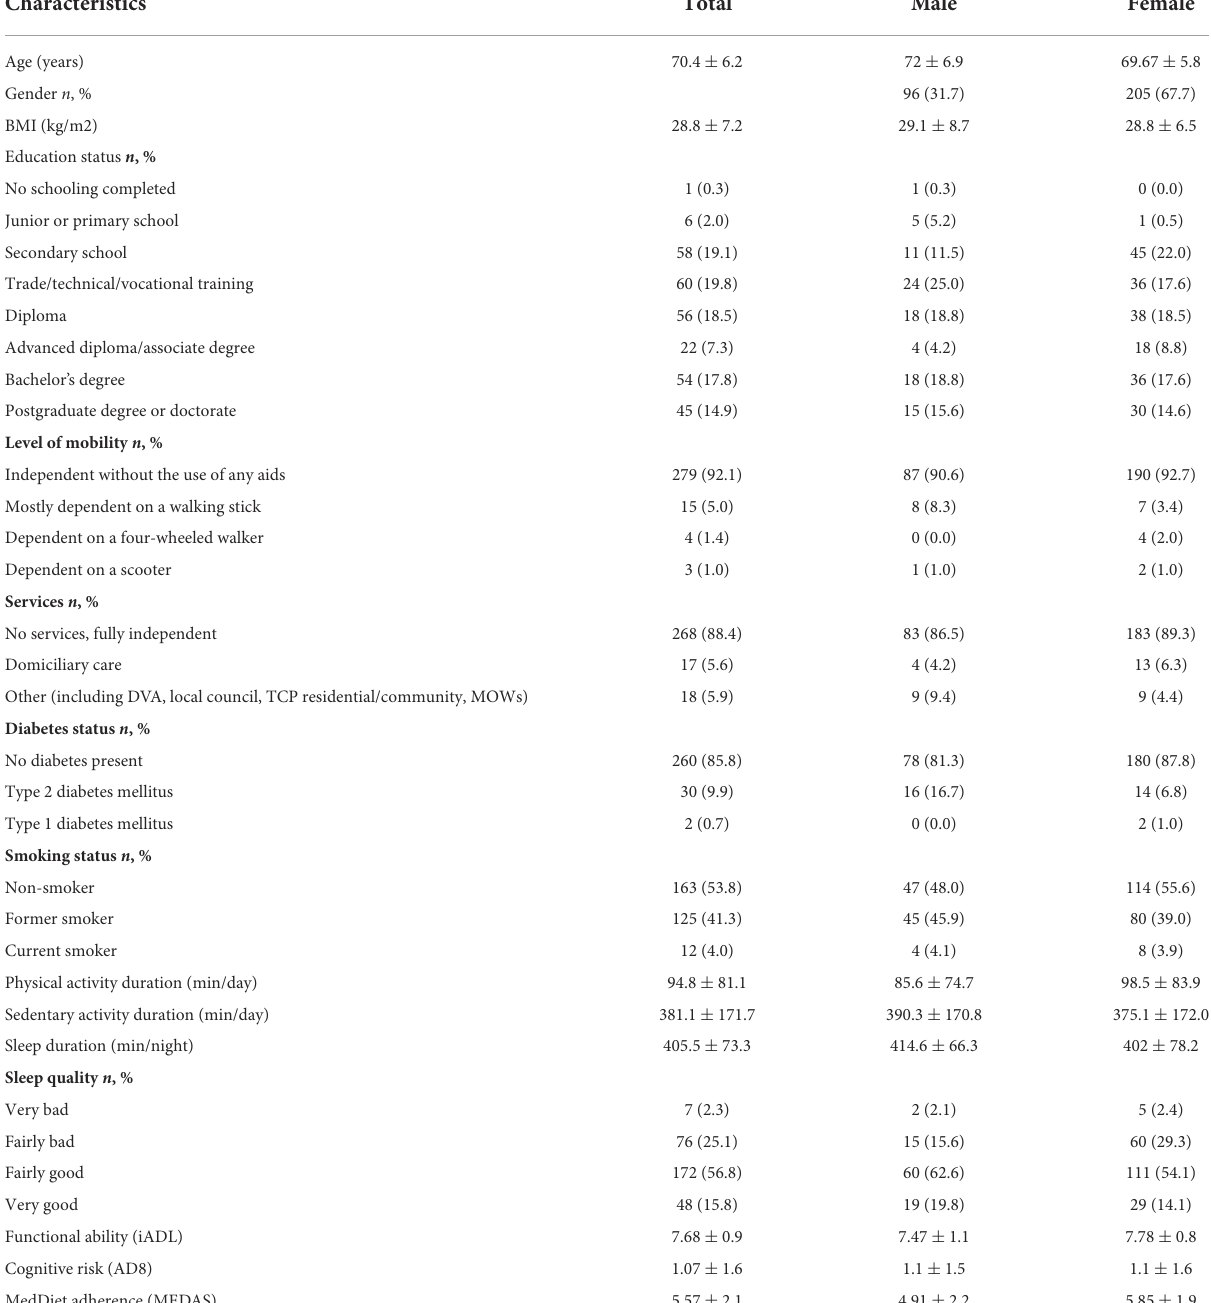
TABLE 1 Participant demographic characteristics by gender *